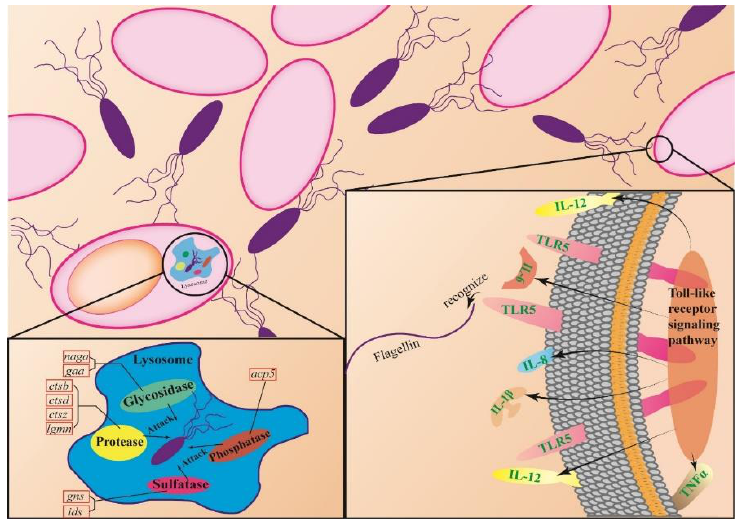
Figure 7. Role of P. plecoglossicida fliA during interaction with L. crocea. The schematic diagram of host pathogen interaction was drawn based on the experimental results of this paper and the literatures. Supplementary Materials: Supplementary materials can be found at http: // www.mdpi.com / 2076-2607 / 7 / 10 / 443 / s1. Figure S1. Eukaryotic base percentage composition reads. Figure S2. Prokaryotic base percentage composition reads. Figure S3. Eukaryotic distribution of mean error. Figure S4. Prokaryotic distribution of mean error. Figure S5. Eukaryotic PCA analysis. Figure S6. Prokaryotic PCA analysis. Figure S7. Verification dual transcriptome data by qRT-PCR. Table S1. shRNA sequences used in this study. Table S2. Primer sequences used in this study.